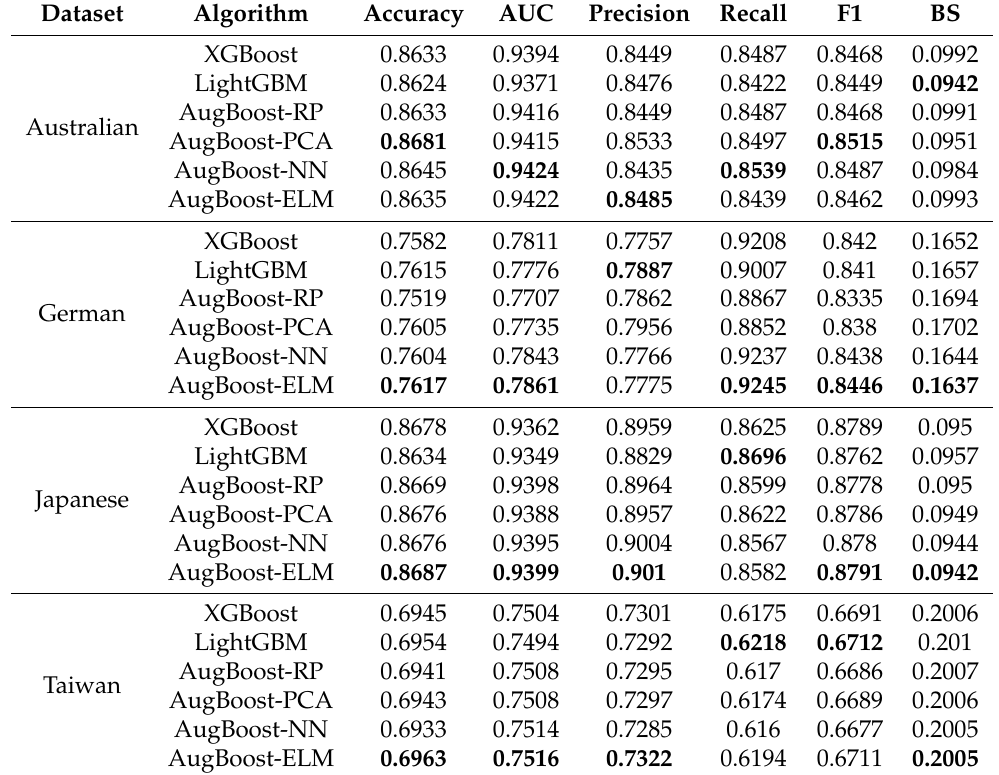
Table 8. Performance comparison of advanced ensemble models for credit